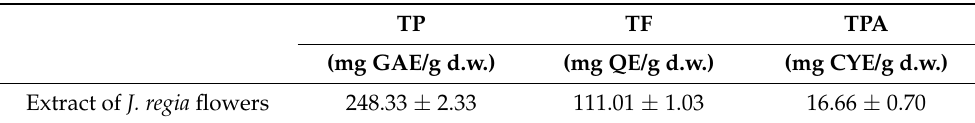
Table 1. The contents of total phenolics (TP), flavonoids (TF), and proanthocyanidins (TPA) of J. regia male flower extracts. TP TF TPA (mg GAE/g d.w.) (mg QE/g d.w.) (mg CYE/g d.w.) Extract of J. regia flowers 248.33 ± 2.33 111.01 ± 1.03 16.66 ±